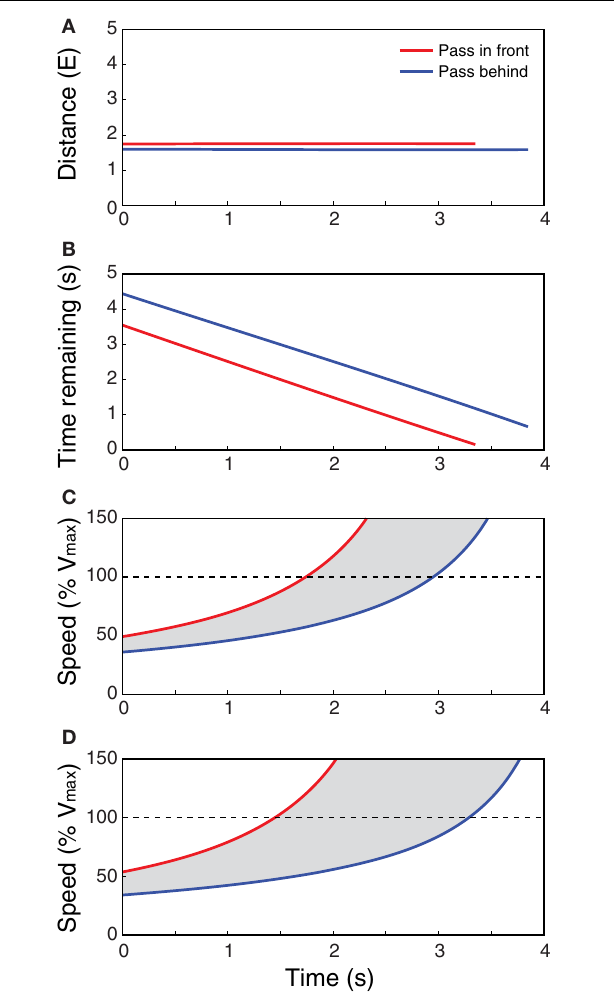
FIGURE 3 | Optically specified distance (A), time remaining (B), and speed (C,D) to pass in front (red line) and behind (blue line) for a stationary observer and a moving obstacle, similar to the situation depicted in Figure 2A. (A–C) Are for a small obstacle, and (D) is for a larger obstacle. Values were calculated using optical variables in Equations 7 and 8. E is the observer’s eyeheight, s is seconds, and V max is the observer’s maximum locomotor speed. Gray area in (C) and (D) indicate range of speeds that would result in a